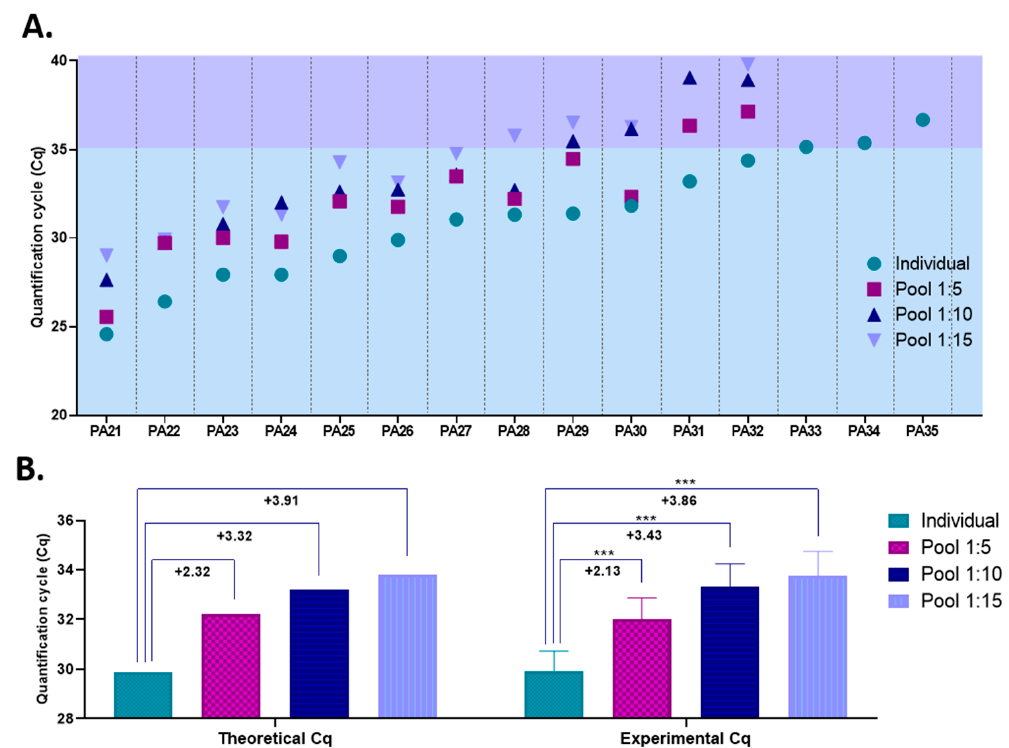
Figure 5. The detection efficiency of SARS ‐ CoV ‐ 2 by RT ‐ qPCR in pooled nasopharyngeal swab specimens from patients with COVID ‐ 19: the comparative Cq values between individual and pooled nasopharyngeal swab specimens in three different ratios (1:5, 1:10, and 1:15), obtained by mixing one COVID ‐ 19 ‐ positive sample with 4/9/14 COVID ‐ 19 ‐ negative samples, for 15 different COVID ‐ 19 ‐ positive patients (PA21 ‐ 35) ( A ); comparison between the expected (theoretical) and experimentally obtained differences between the Cq values at which individual and pooled nasopharyngeal swab specimens were detected ( B ). In ( B ), (experimental Cq) data are presented as mean ± SEM of Cq values of all 15 individual or pooled samples, whereas the statistical significance was assessed by a paired t ‐ test ( p *** < 0.001).